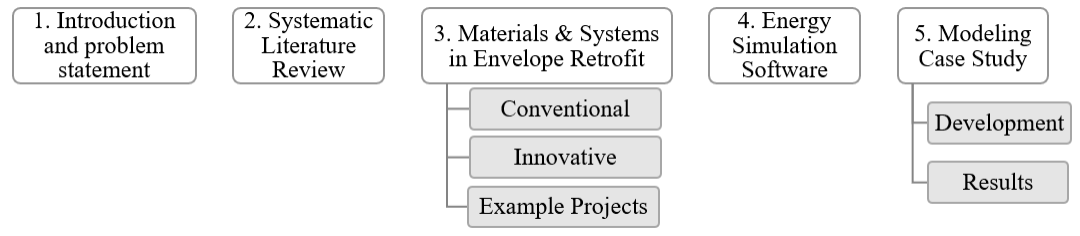
Figure 4. The paper’s overview.